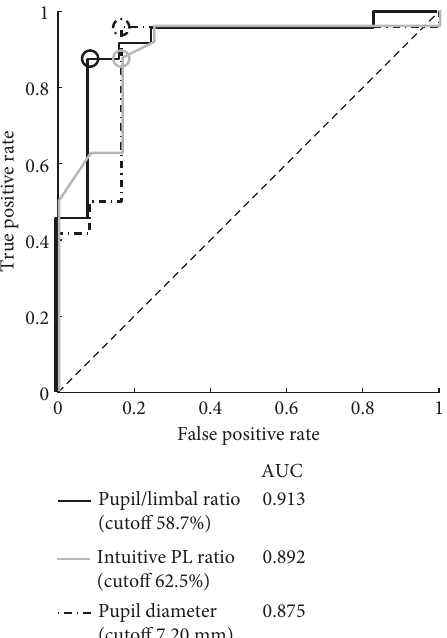
Figure 3: ROC curves to predict intraoperative floppy iris syn- drome (IFIS). ROC curves for IFIS incidence dependent on the pupil diameter (dashed line), the pupil-to-limbal diameter (PL) ratio (solid line), and the intuitive PL ratio (gray